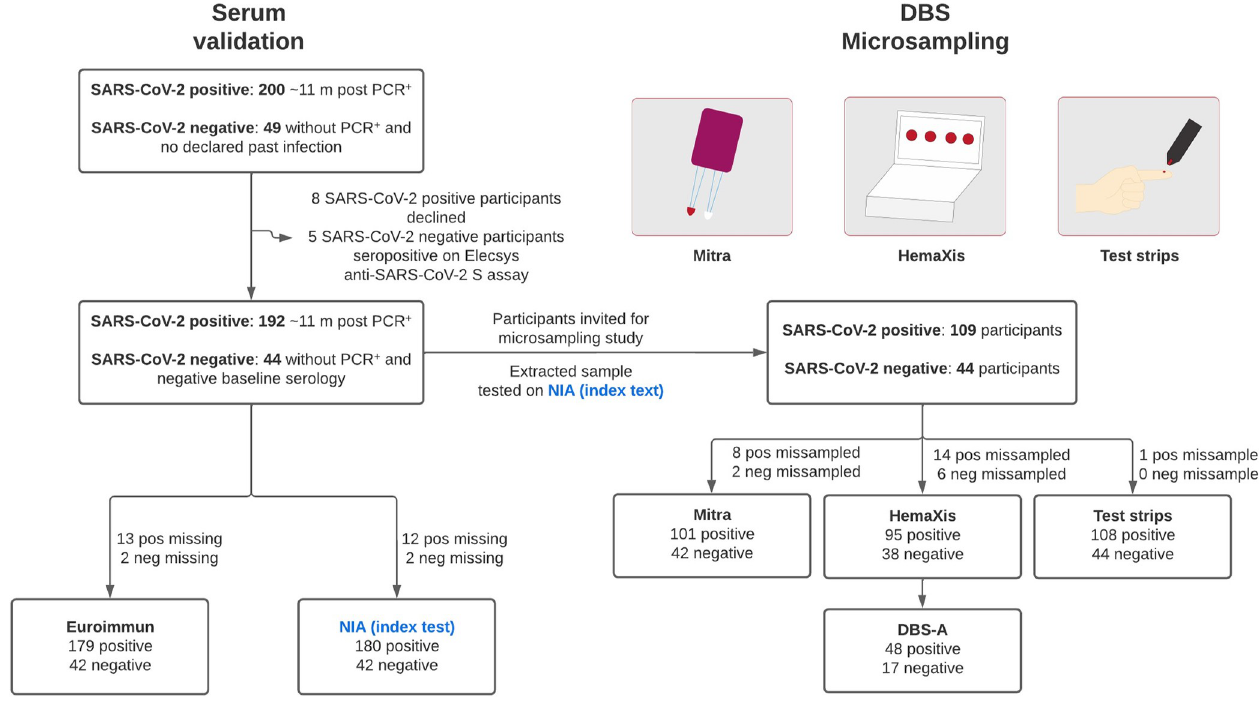
Fig 1. Study participants. Serum validation) 249 participants were included in this study and were invited for a venipuncture. Serum obtained was used for testing on the reference standard Roche Elecsys anti-SARS-CoV-2 S total Ig assay, Euroimmun anti-S1 IgG assay, and on the microfluidic nano-immunoassay (NIA) index test. DBS microsampling) On the same day, the participants were invited to perform a capillary blood collection using three different microsampling devices: Mitra, repurposed glucose test strips, and HemaXis. The samples were shipped by regular mail in a dried state and extracted upon reception. For filter cards collected with the HemaXis device, a subset of samples was extracted by flowthrough desorption using an automated instrument (DBS-A, Gerstel AG).